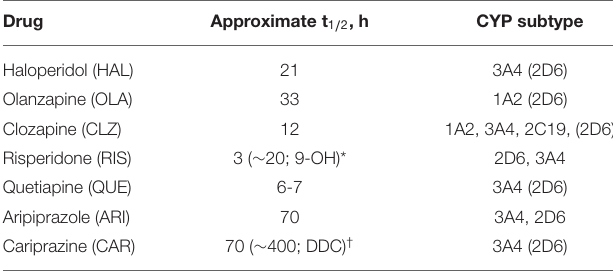
TABLE 3 | Examples of commonly used antipsychotics, their t 1 / 2 , and main metabolic enzymes.